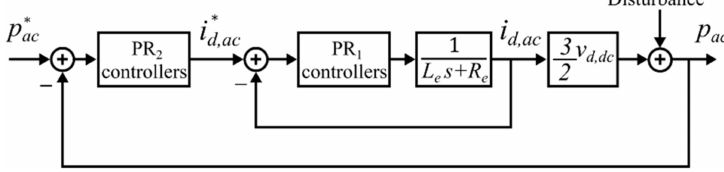
Figure 8. Power ripple closed-loop control block